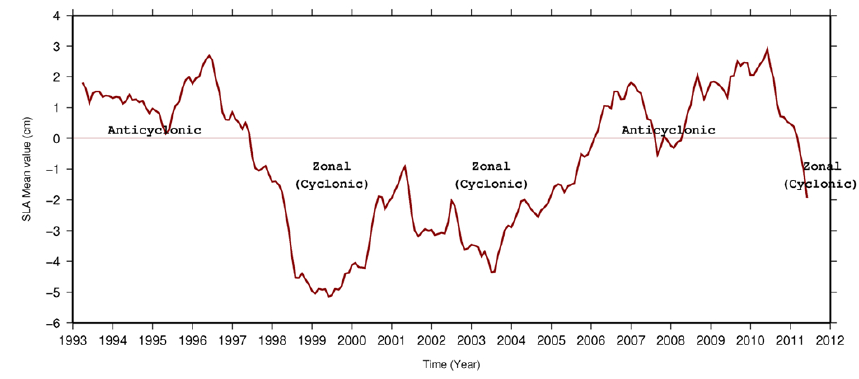
Fig. 11. Time series in the Ionian region during the period 1993–2011 of mean SLA in box S1 as defined in Figure 10 (top panel), units in cm. The red level is shown in order to differentiate the NIG phases: the “anticyclonic” phases (above red level) and the “cyclonic” phases (under red